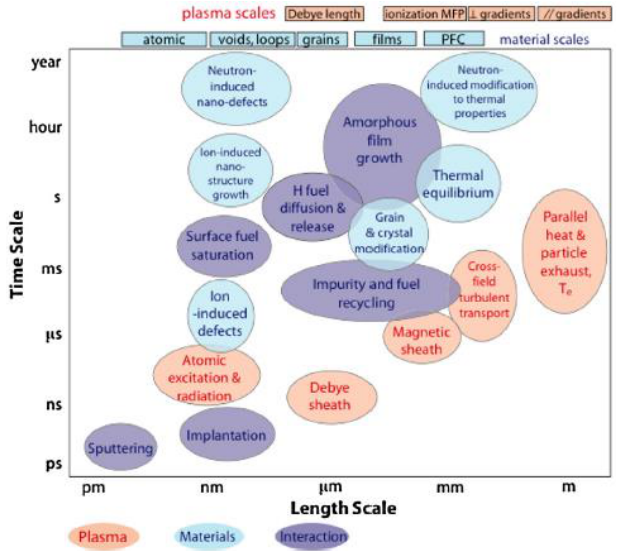
Figure 4. Overview of the coupled multi-scale phenomenon associated with plasma-materials interactions. This figure is taken from [87].